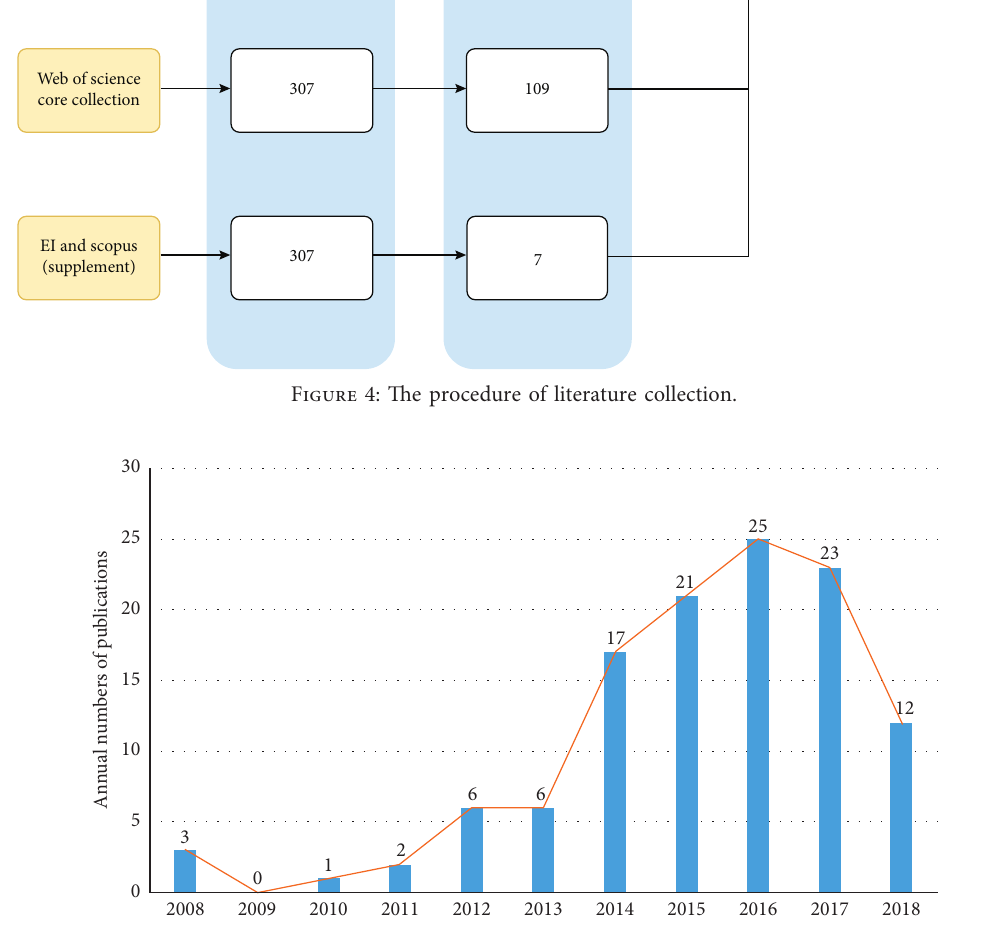
Figure 5: Year profile of publications. Table 1: Distribution of research areas from Clarivate Analytics.